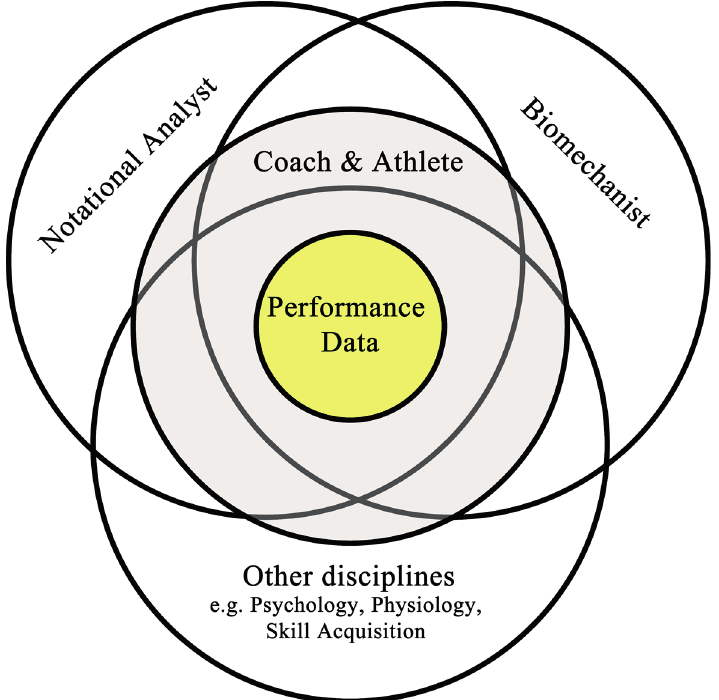
Figure 1. The digital systems data interactions with various other team members. Based on